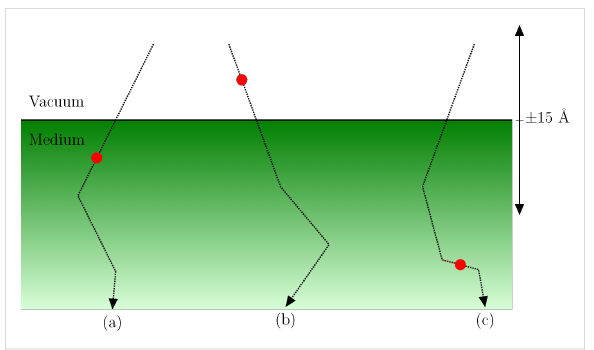
Figure 1: Example incoming trajectories (dotted lines) in the surface- scattering zone (typically 15 Å above and below the surface), under- going (a) a surface energy loss in the medium side, (b) a surface energy loss in the vacuum side, (c) a bulk energy loss, indicated by the filled